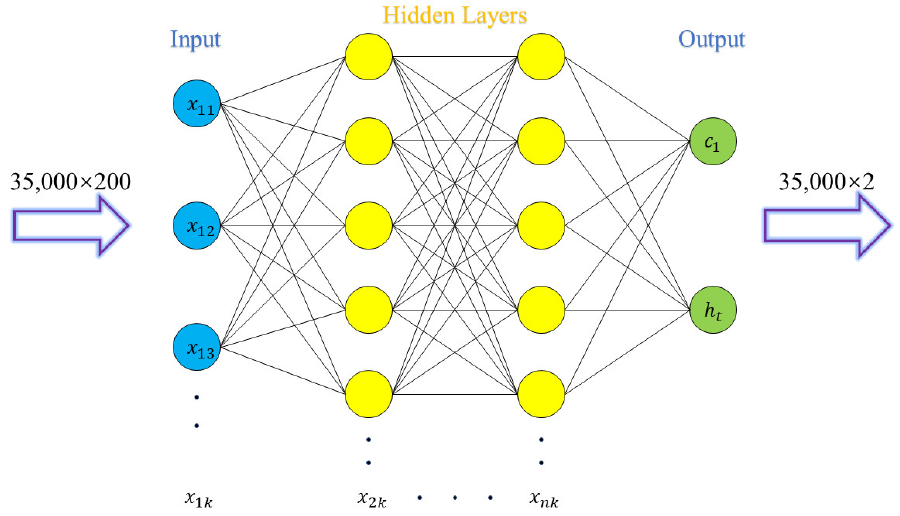
Figure 4. Deep neural